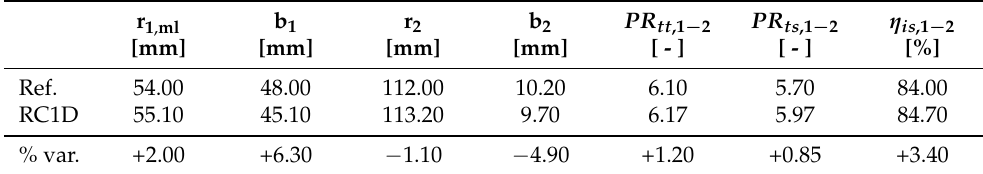
Table 3. Centrifugal compressor design—procedure calibration [19]. Subscripts 1 and 2 indicate impeller inlet and outlet sections, respectively.